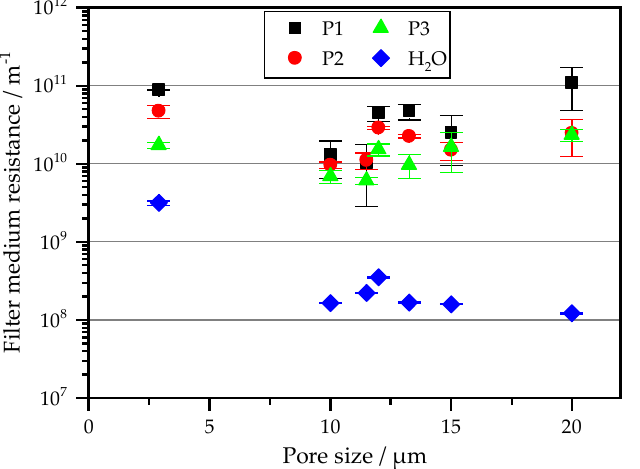
Figure 7. Overview of the fabric resistances in m −1 of the plastic-based multifilament fabrics (Table 2) with interaction of the particles from Figure 2.